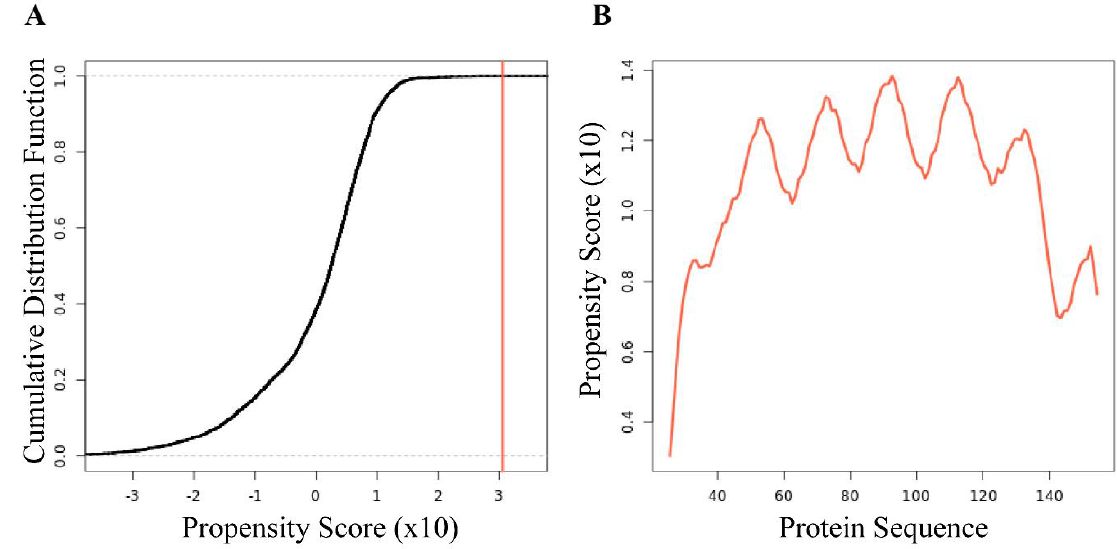
Figure 8. The bioinformatics program catGranule predicts that Af LEA1 has a high propensity towards liquid – liquid phase separation in the presence of RNA. ( A ) A cumulative distribution fraction analysis of the amino acids of Af LEA1 produces a propensity score of 3.05, and a score > 1 is a predictor of LLPS behavior. ( B ) The residue-level propensity of Af LEA1 to undergo LLPS, where values above 0 indicate an increased likelihood of undergoing LLPS in the presence of RNA.